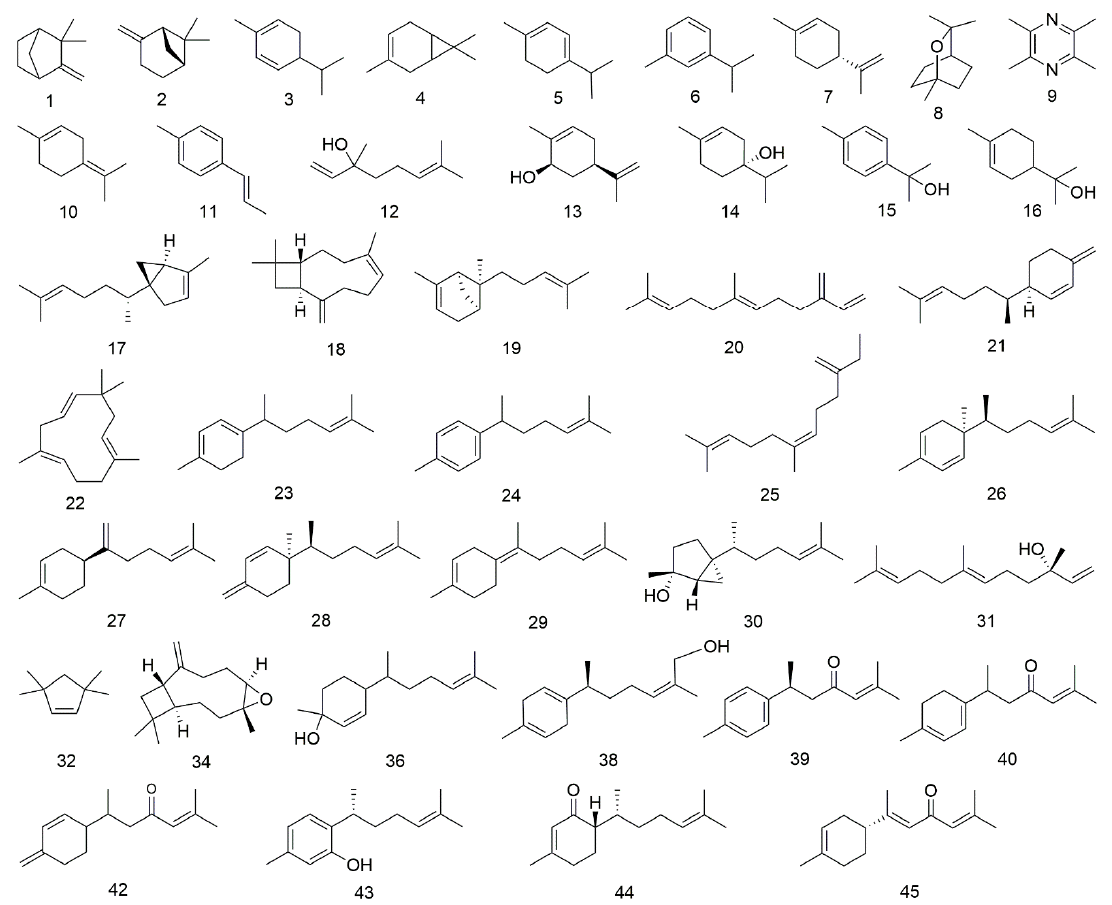
Figure 2. Chemical structures of the compounds identified from RCL and RHCL.